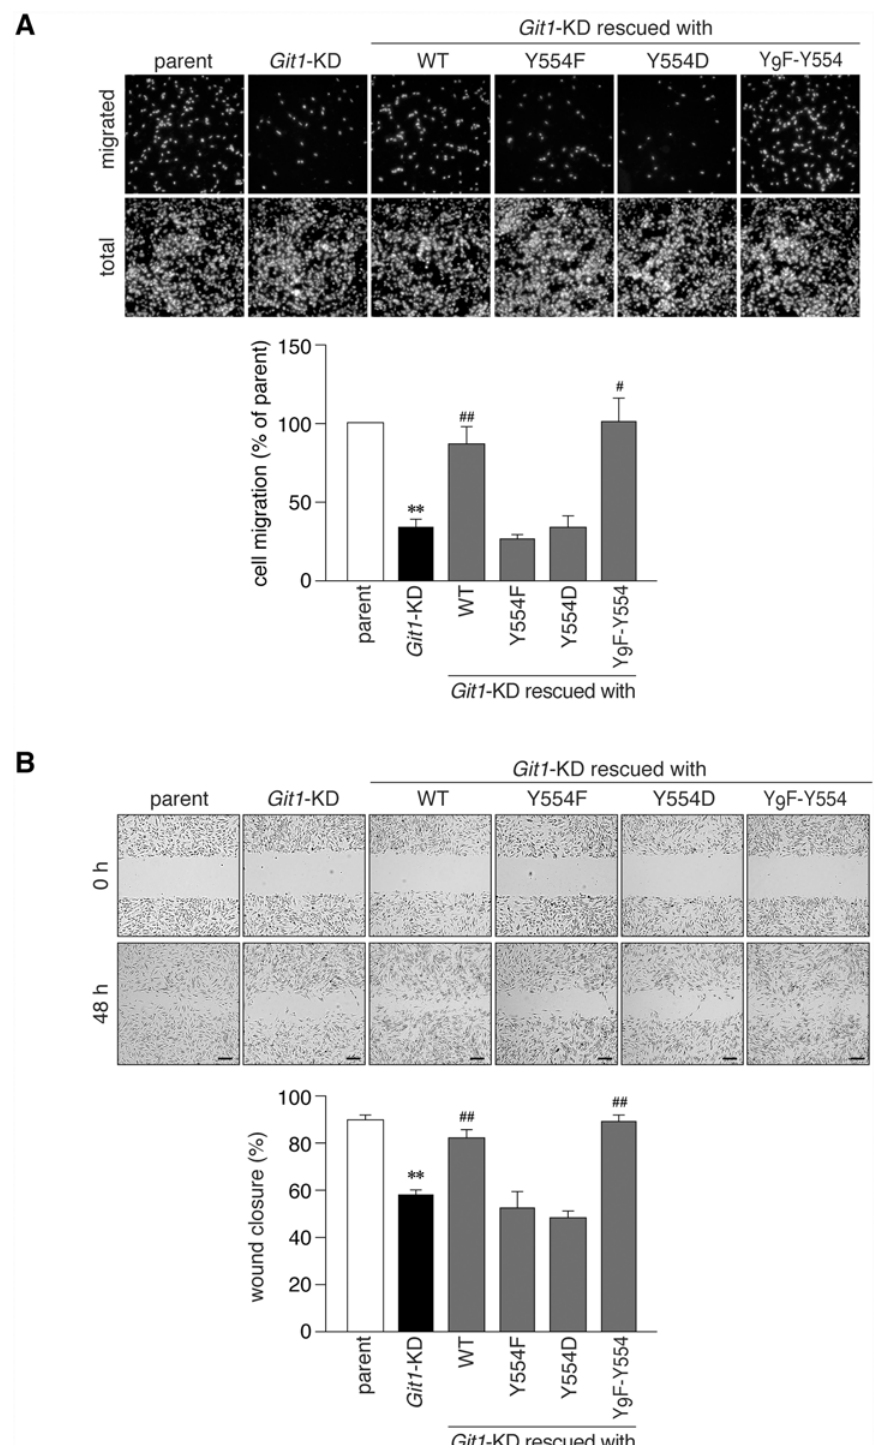
Fig 8. Git1 Tyr-554 mutants failed to restore cell mobility impaired by Git1 knockdown in Boyden chamber and wound healing assays. A , The Boyden chamber assay. Parental A7r5 cells or Git1 -KD cells transfected with an mCherry or mCherry-fused Git1 construct were plated on the upper compartment of the fibronectin-coated chamber, and allowed to migrate to the lower side of the filter for 6 h. DAPI-stained nuclei were counted before (total) and after (migrated) the removal of cells remaining in the top chamber with